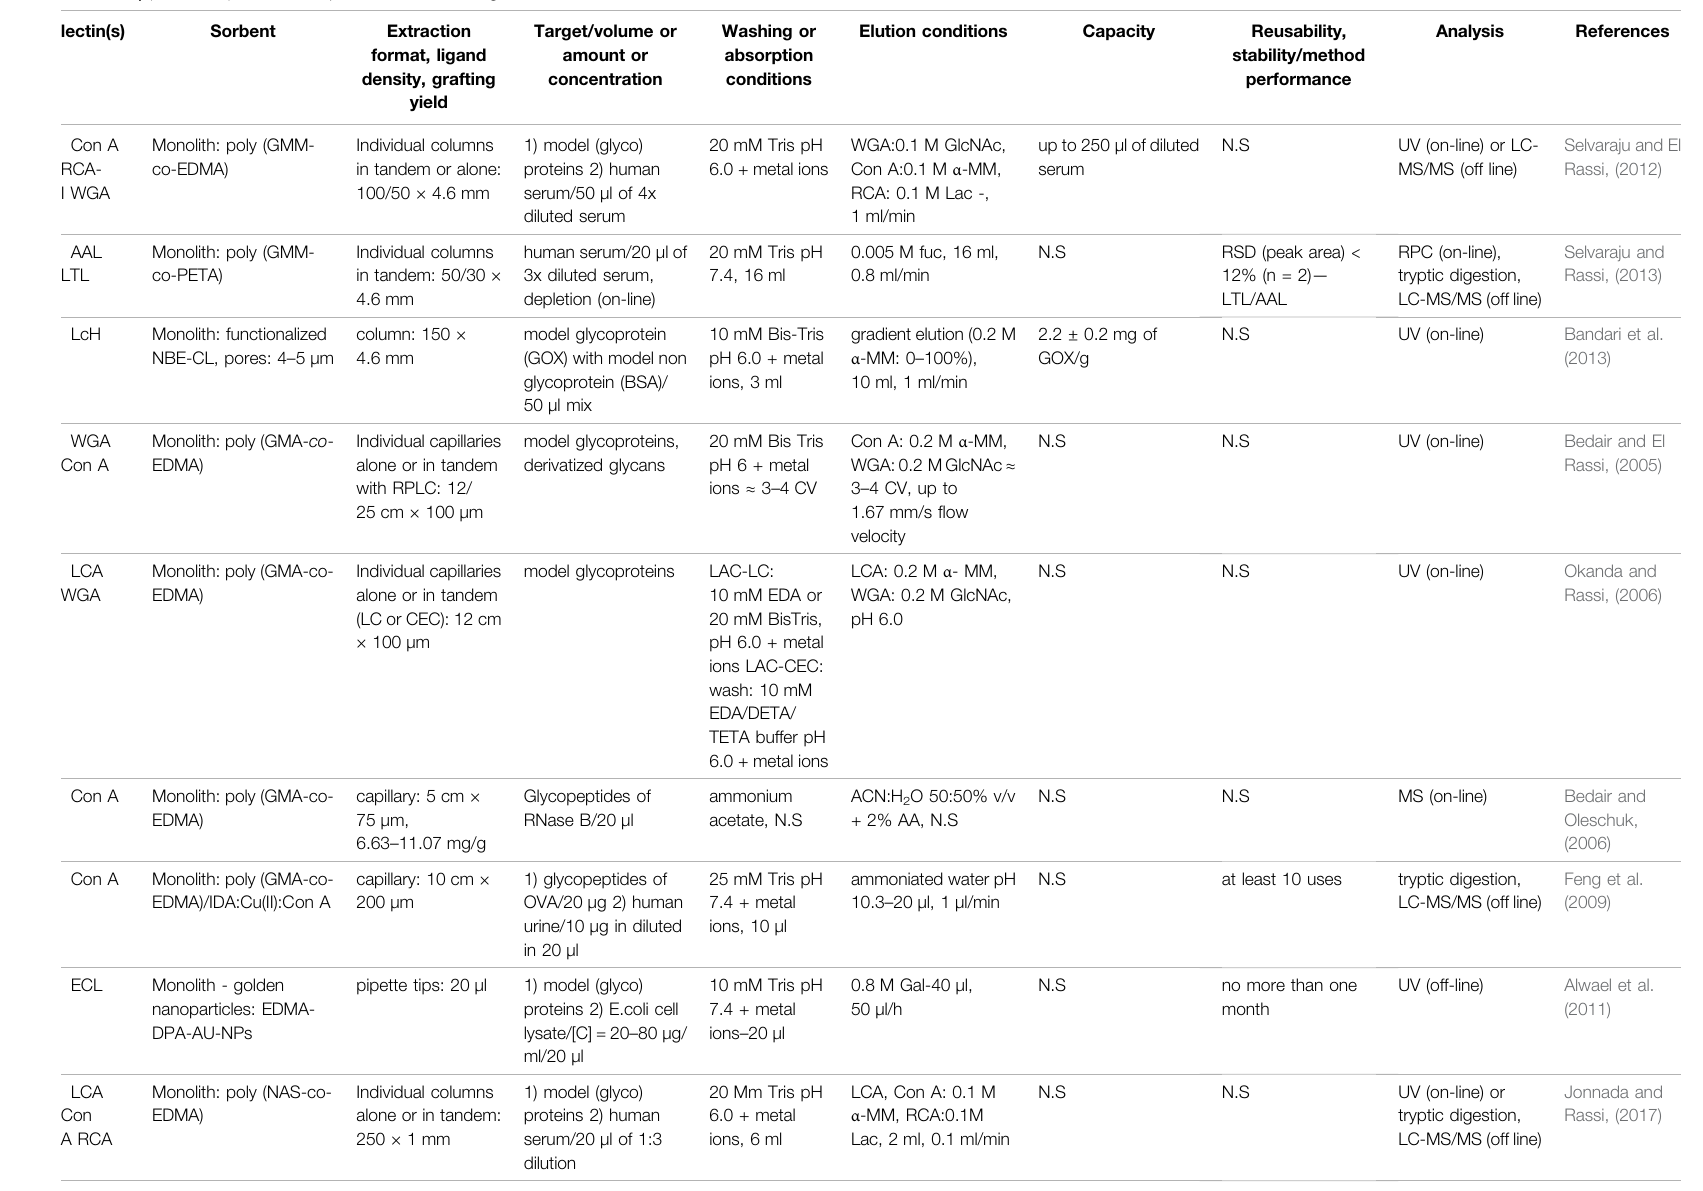
TABLE 4 | ( Continued ) Lectin solid phase extraction using home-made